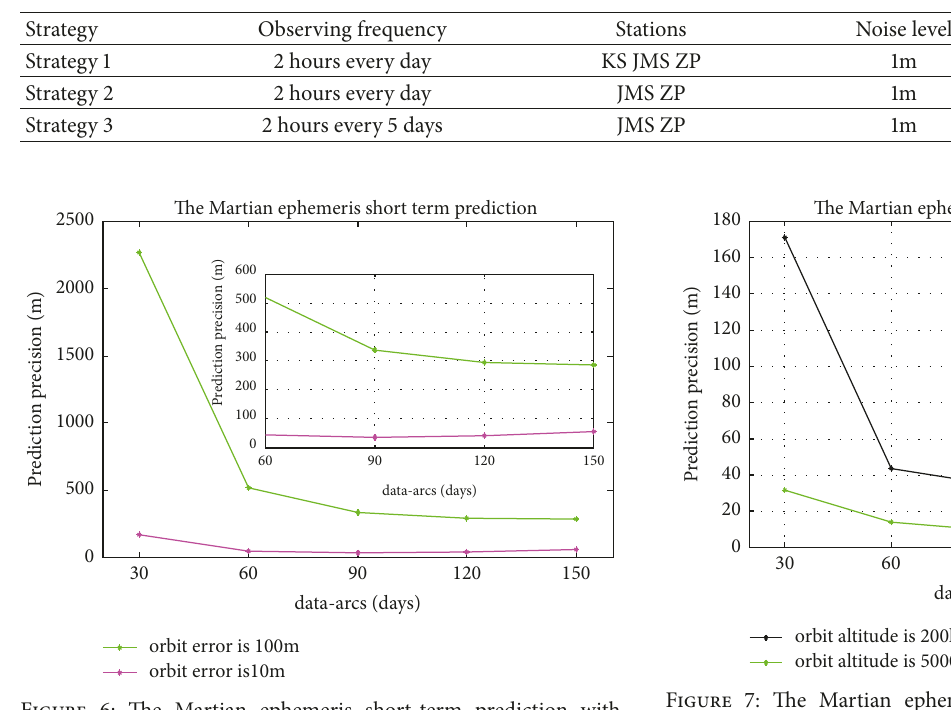
Table 5: Observing strategies and the accuracy of range measurements.